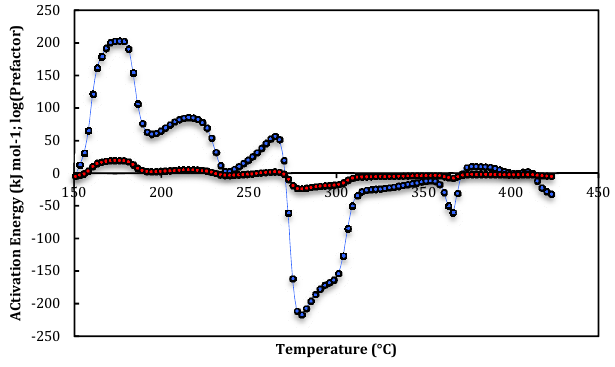
Figure 3. Apparent activation energies (blue circles) and prefactors (red circles) plotted against temperature for the third temperature-programmed run for isobutene evolution over HZSM-5.